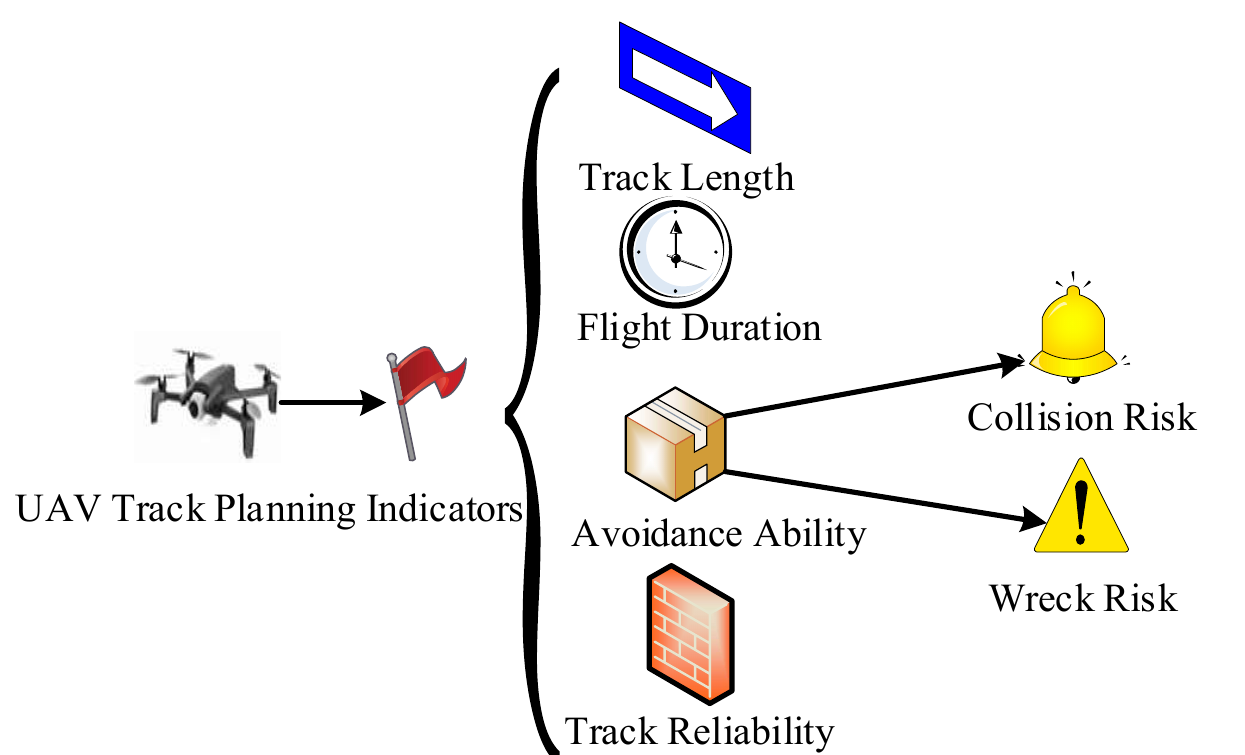
Figure 4. Evaluation index diagram of UAV track planning.